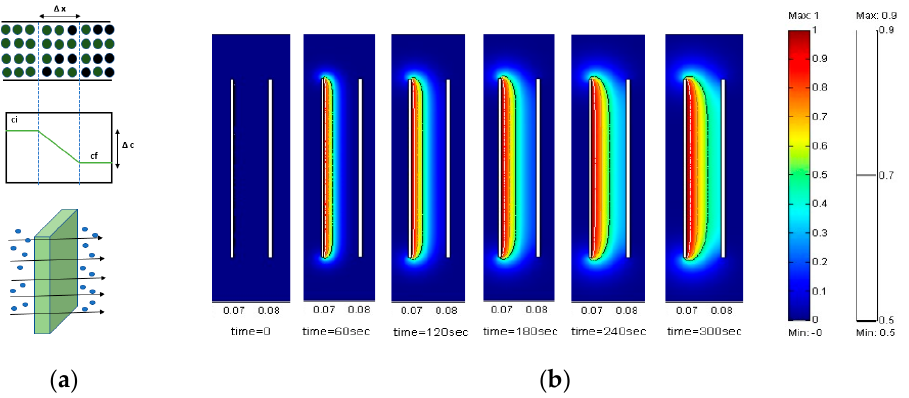
Figure 12. ( a ) The movement of ions from surface of anode based on the concentration gradient developed in electrolytic solution. ( b ) Formation of uniform and thick viscous film at anode for various time intervals at constant diffusion coefficient (D = 10 − 7 cm/s ) [118], open access provided by WIT press 2005.